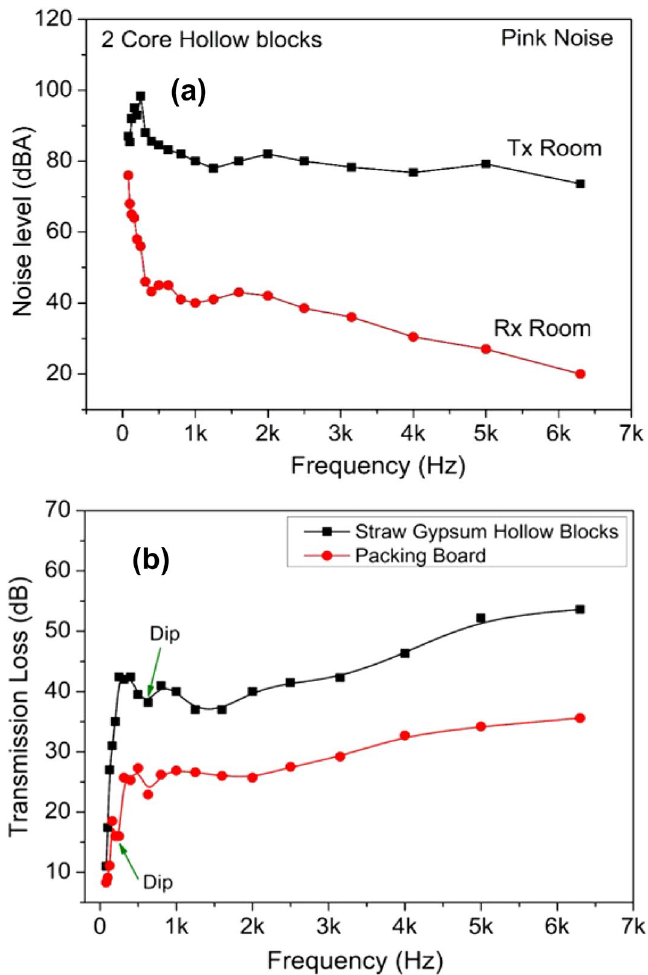
Figure 10. ( a ) Noise level and transmitter and receiver room; and ( b ) STL values of two-core hollow blocks test wall and packing board by reverberation chamber